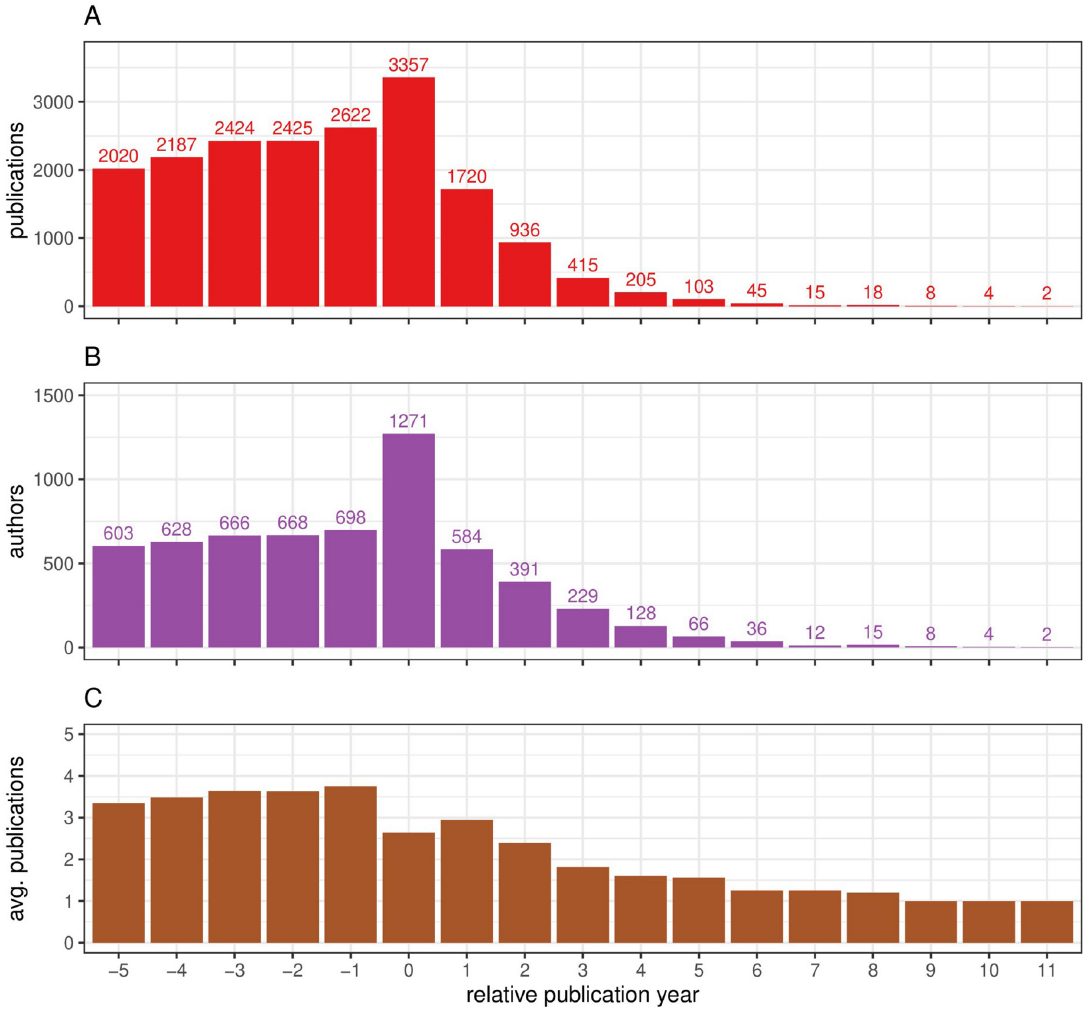
Fig 6. The timeline of publications by deceased authors. The span of cumulative publications by the total pool of the deceased author cohort (n = 1439) from 5 years prior to the year of death till 11 years after the year of death is depicted in (A) red bars and the numbers of authors (B) in blue, with average publications per author (C) in brown. The count represents actual numbers of both publications and deceased authors for each